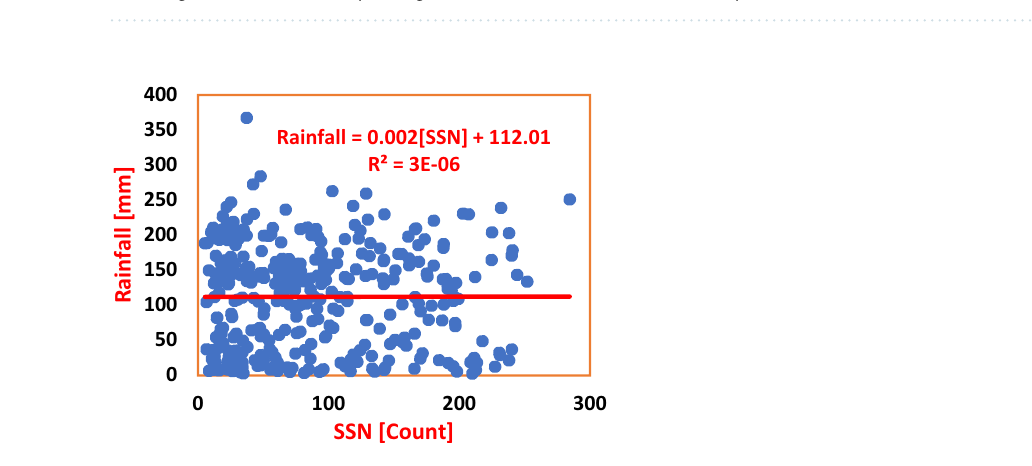
Figure 5. Regression of SSN on Rainfall in ABD during Solar Cycles 22–24. SSN made a 0.003% influence on SAT. The Regression Equation shows that a unit increase in SSN by I Count resulted to an insignificant decease in SAT by an average of 0.002